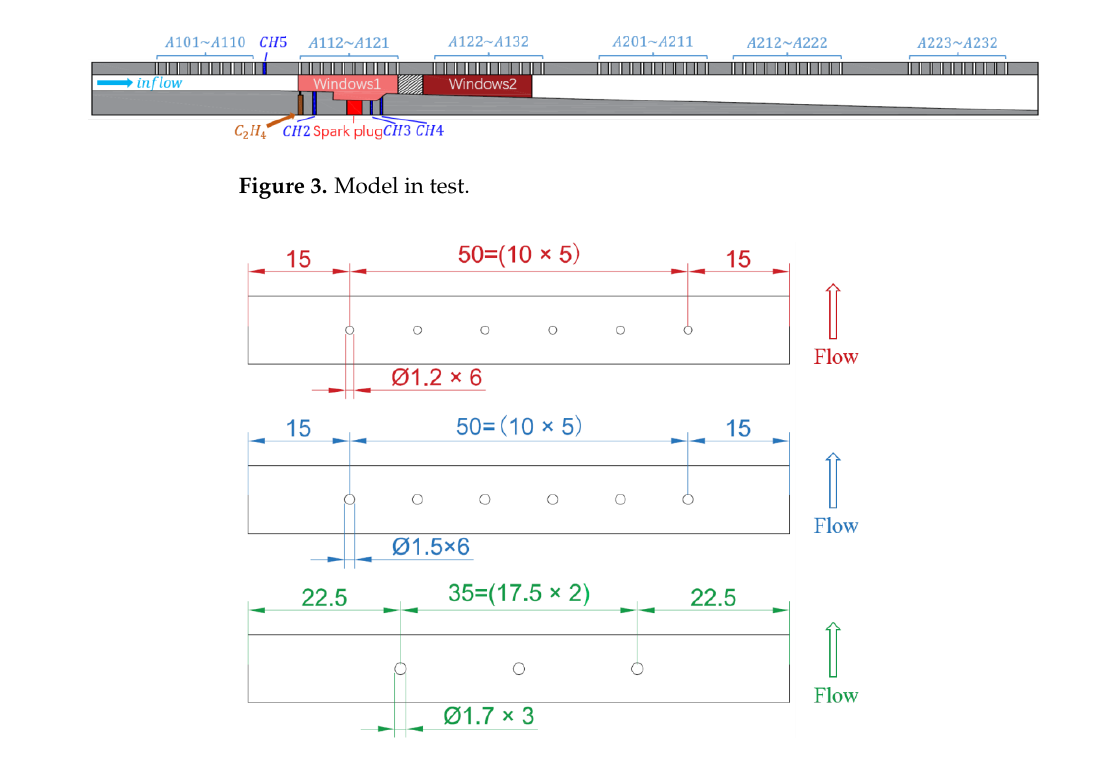
Figure 4. Three injection schemes.